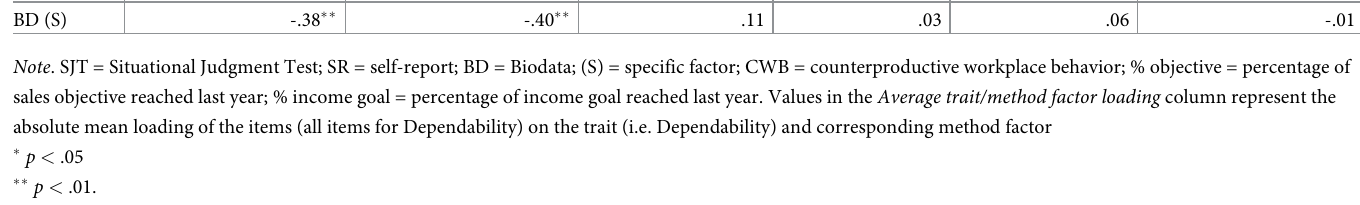
The correlations between the factors and outcomes are presented in Table 5. As expected, the overall Dependability factor was related to lower counterproductive workplace behavior and turnover intentions, as well as higher job satisfaction and percentage of sales objectives and income goal reached. Surprisingly, a higher SJT score also seemed to result in lower job satis- ing for the common variance across the three Dependability measures. This might indicate that participants with higher scores in such low fidelity work situations also have a higher ten- dency to leave their current position, possibly because they feel they deserve better employ-